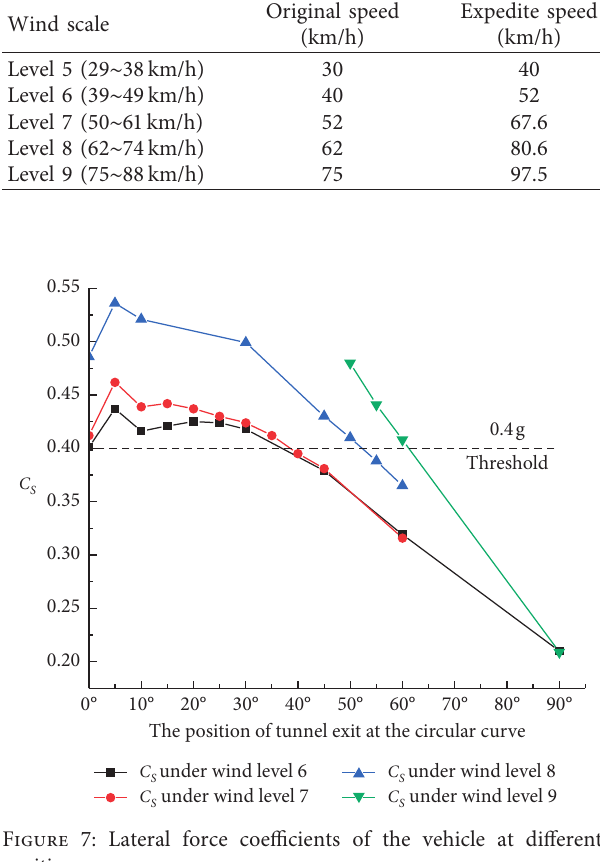
Figure 9: Vehicle roll over under level 9 wind scale.